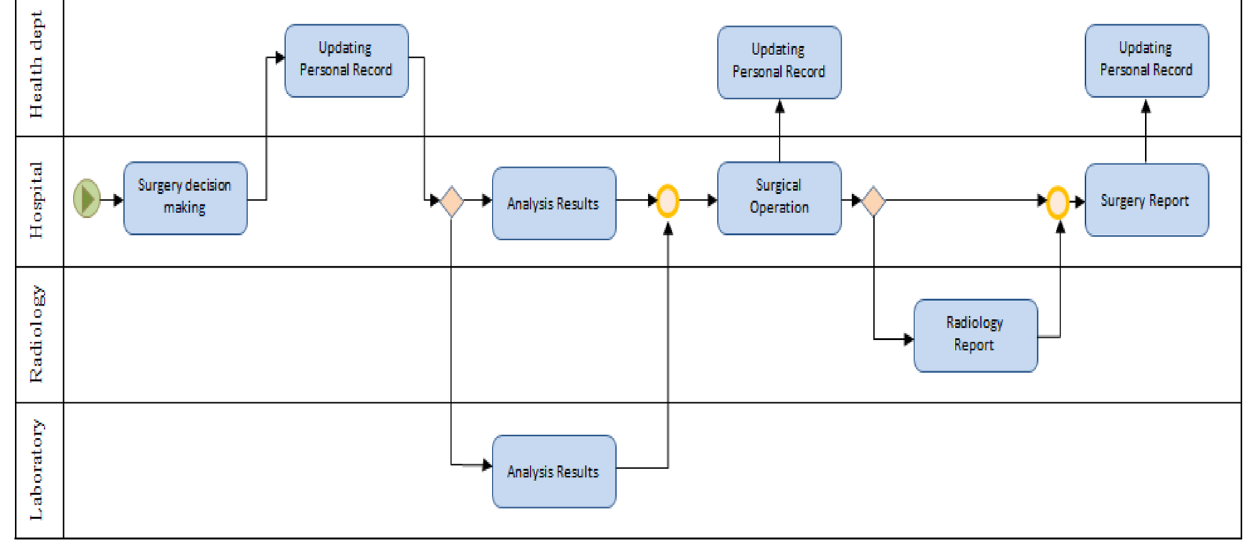
Fig. 4. Collaborative surgical operation process.